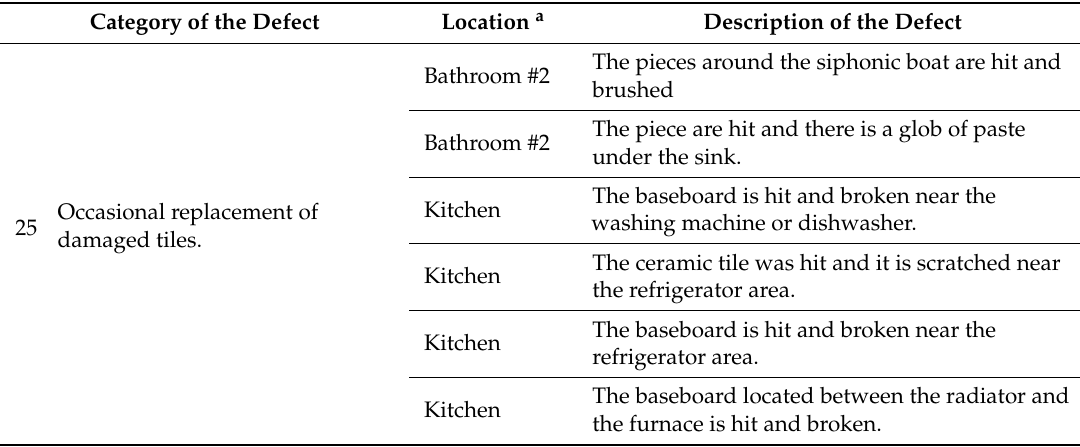
Category of the Defect Location a Description of the Defect The pieces around the siphonic boat are hit and Bathroom #2